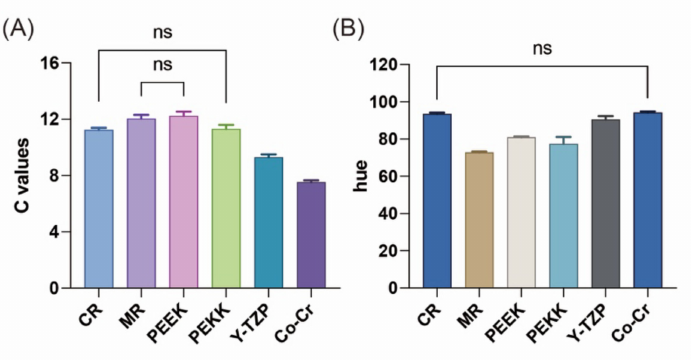
Figure 4. Results of average ( A ) chroma (C) values and ( B ) hue (h) under different substrate groups. No statistical differences between groups are shown as